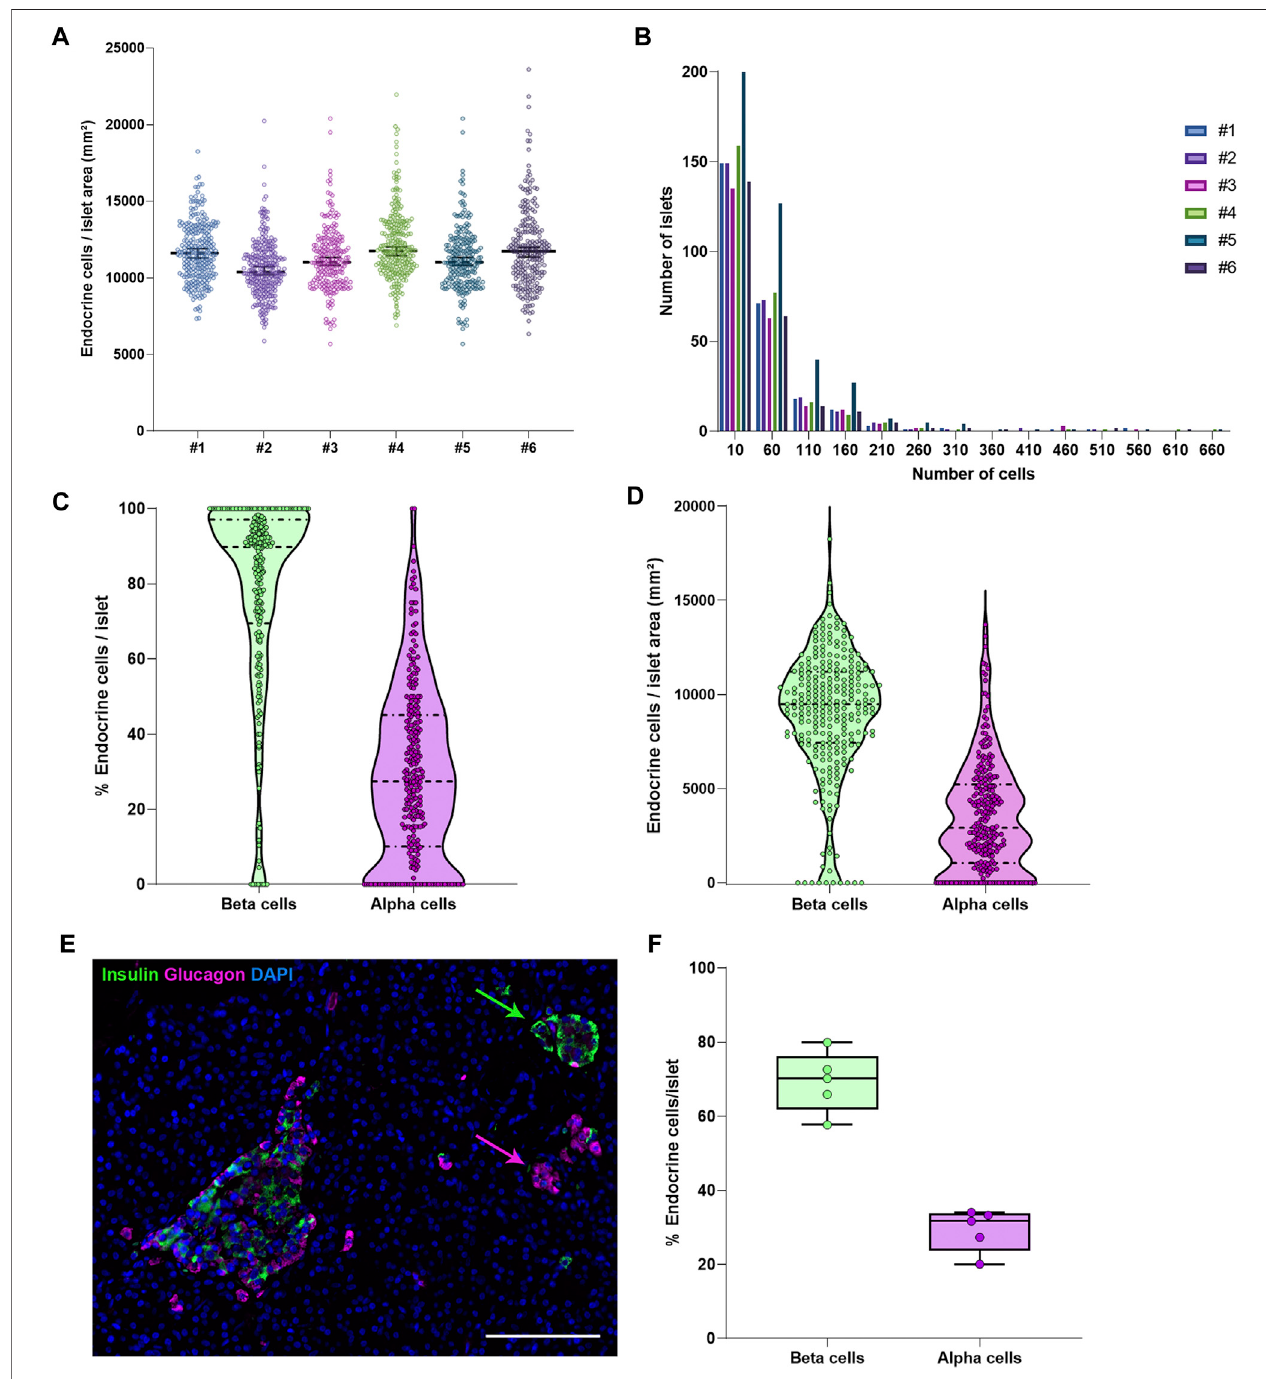
FIGURE 3 | Characterization of the endocrine and exocrine pancreas in a non-diabetic donor. (A) Comparison of islet density expressed as number of endocrine cells per islet area in mm 2 among the different staining combinations. Each dot represents an islet. (B) Histograms showing the cellular content of islets in pancreatic sections stained with different antibody combinations. The different staining IDs are shown as #1 – 6. Each bar represents a different slide. More details can be found in Supplementary Table S1 . (C) Violin plots showing the percentage of endocrine cells (beta and alpha cells) per islet analyzed in the whole pancreatic section, stainedwithantibodycombination#1.Eachdotcoloredrepresentsanislet. (D) Violinplotsshowingthedensityofbetaandalphacellsinthesamesection,expressedas number of endocrine cells per mm 2 of islet area. Each dot represents an islet. (E) Representative image showing two islets, one containing mainly beta cells (green) and onecontainingmainlyalphacells(magenta). (F) Boxplots showingthemeanpercentage ofbetaoralphacellsper islet.Eachdotrepresentsthemeanfromasingleslide. Scale bar: 100 μ